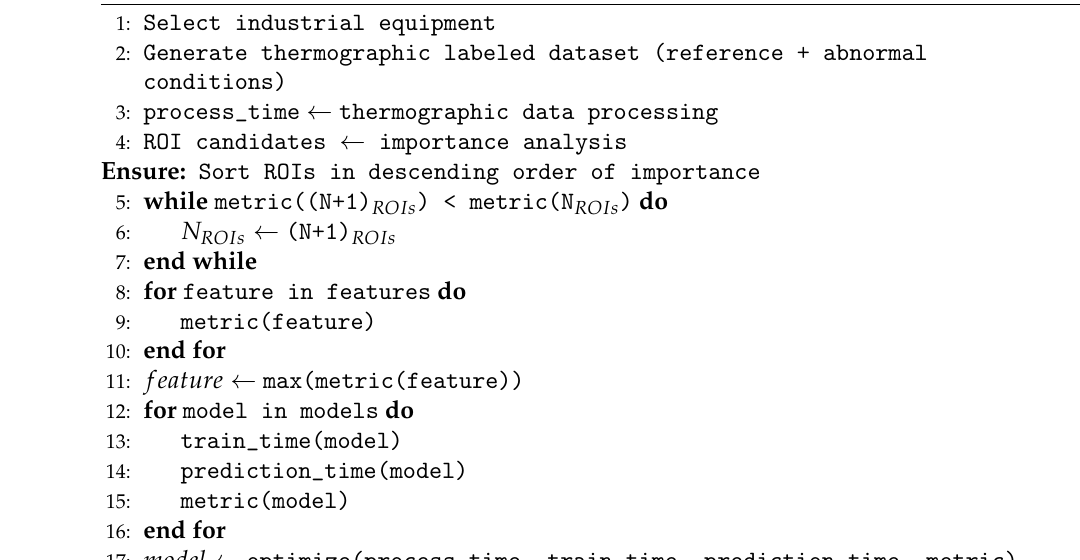
Algorithm 1 An algorithm proposed to develop a robust and fast predictive maintenance system based on thermographic